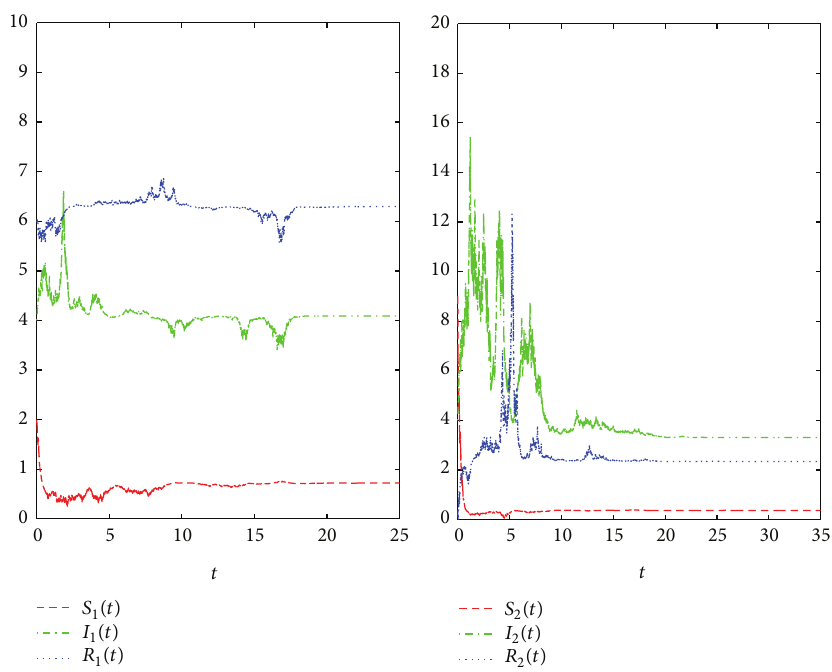
Figure 3: Stochastic trajectories of SIRS model (12) for 𝜎 11 = 0.7 , 𝜎 21 = 1.2 , 𝜎 31 = 1.3 , 𝜎 12 = 0.8 , 𝜎 22 = 0.8 , 𝜎 32 = 1.4 , and Δ𝑡 = 10 −3 .